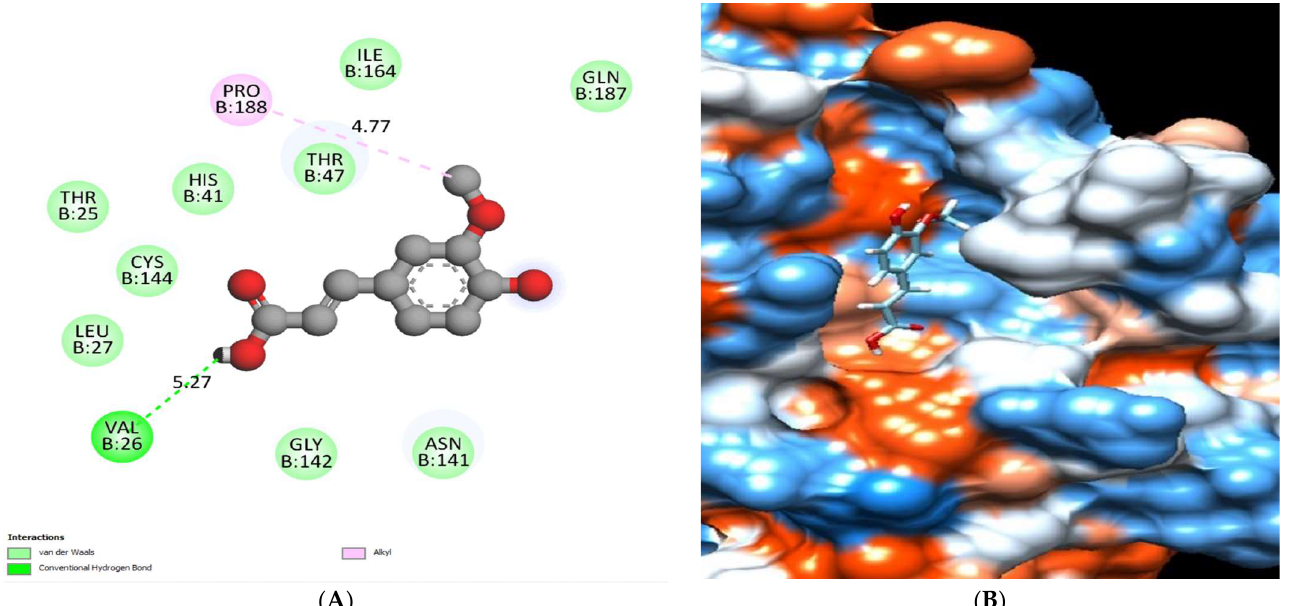
Figure 14. Ferulic acid docked in HCo-V 229E main protease hydrogen bonds are represented in green and the pi interactions are represented in pink lines ( A ), with a mapping surface showing ferulic acid occupying the active pocket of HCo-V 229E main protease ( B ).